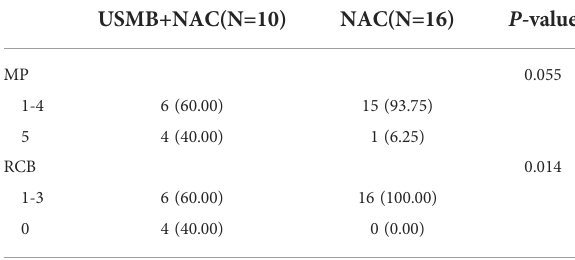
TABLE 3 Comparison of pCR rate between USMB+NAC and NAC